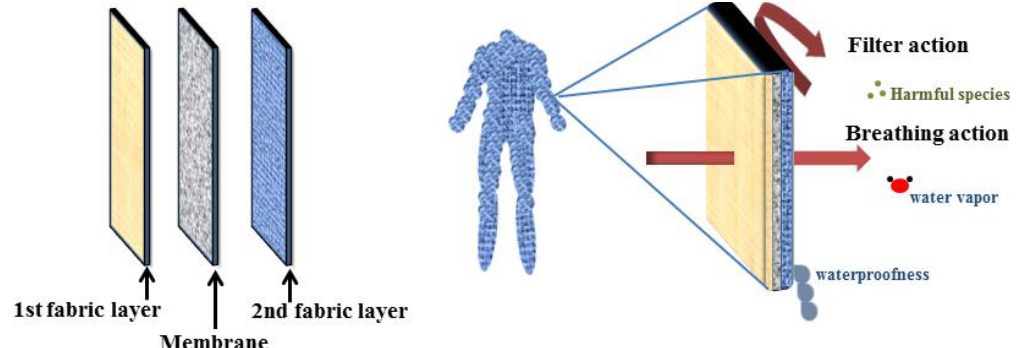
Figure 15. A breathable barrier membrane acting as protective clothing